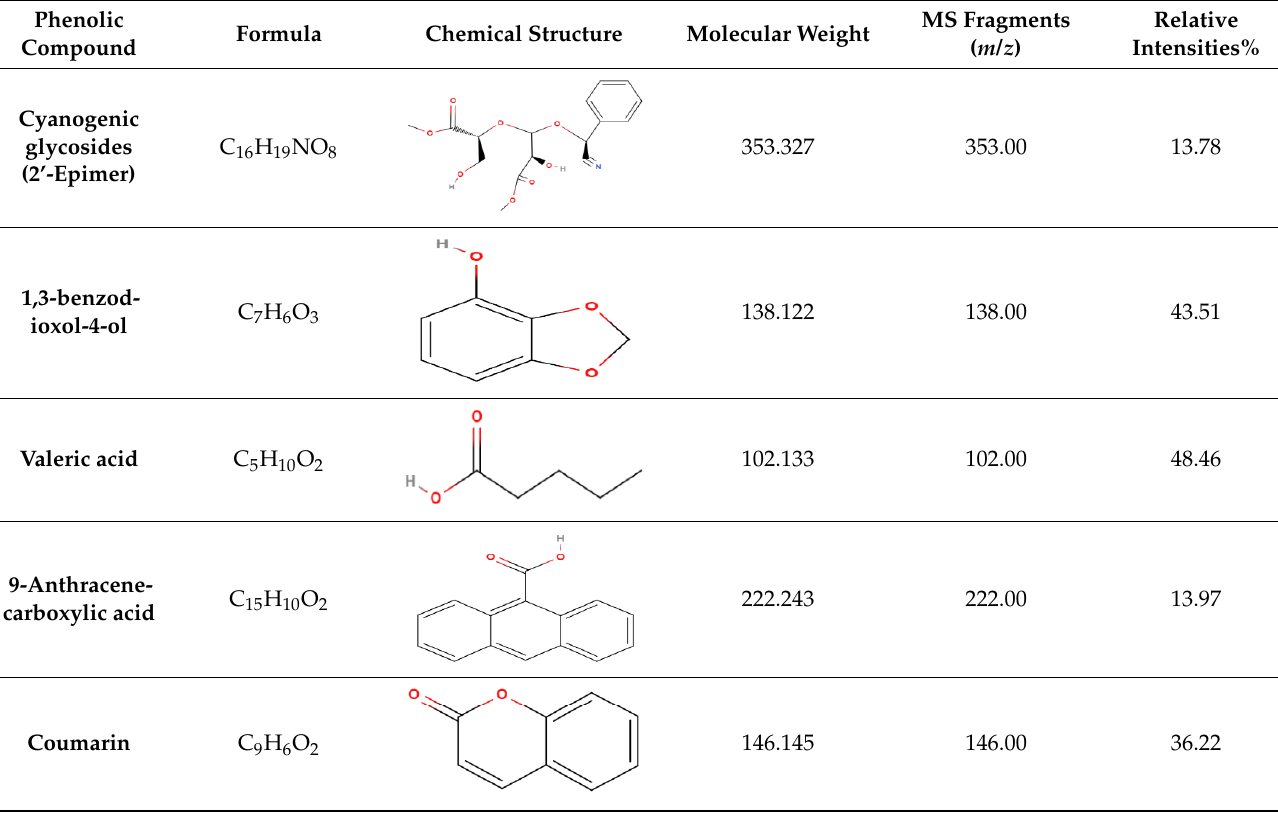
Table 1. GC-MS analysis results of A. factorovskyi ethanolic extract.